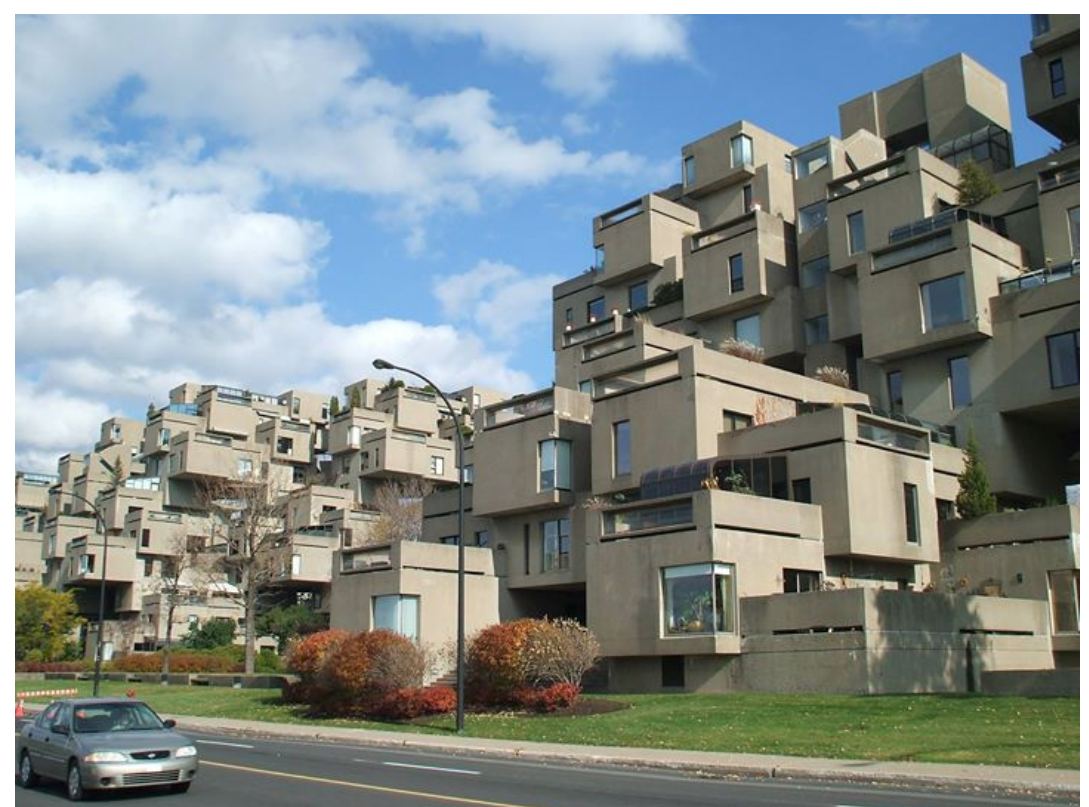
Figure 3. The Habitat 67 project in Montreal (Picture: Ifte